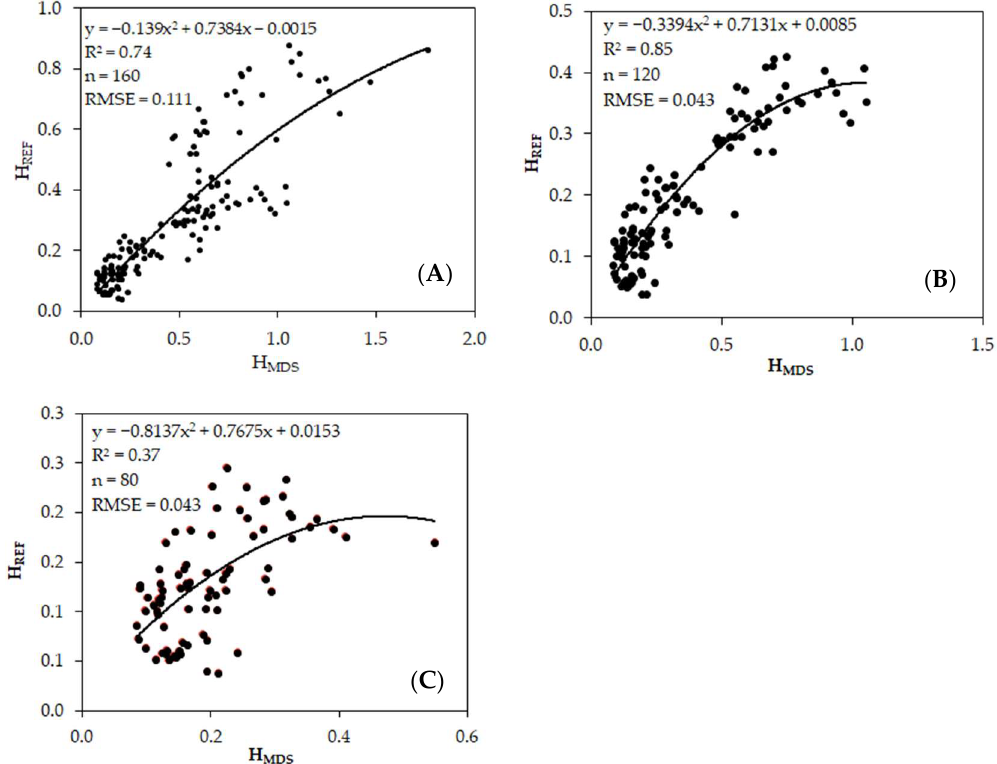
Figure 3. Regression models between H REF and H DSM . ( A ) Regression model using all data; ( B ) regression model using data collected up until and including the flowering stage; ( C ) regression model using data collected up until and including booting stage. RMSE = Root Mean Square Error (m), n = number of observations. For all models p < 0.05.